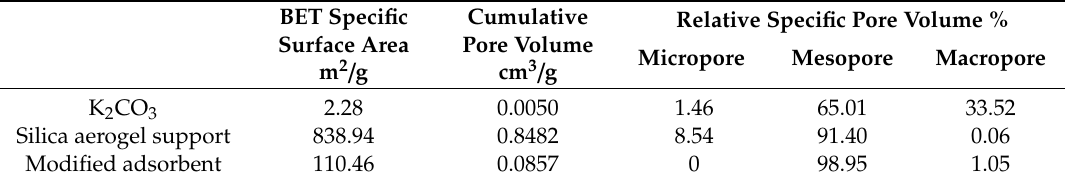
Table 2. Pore structure parameters of active component, support, and adsorbent.